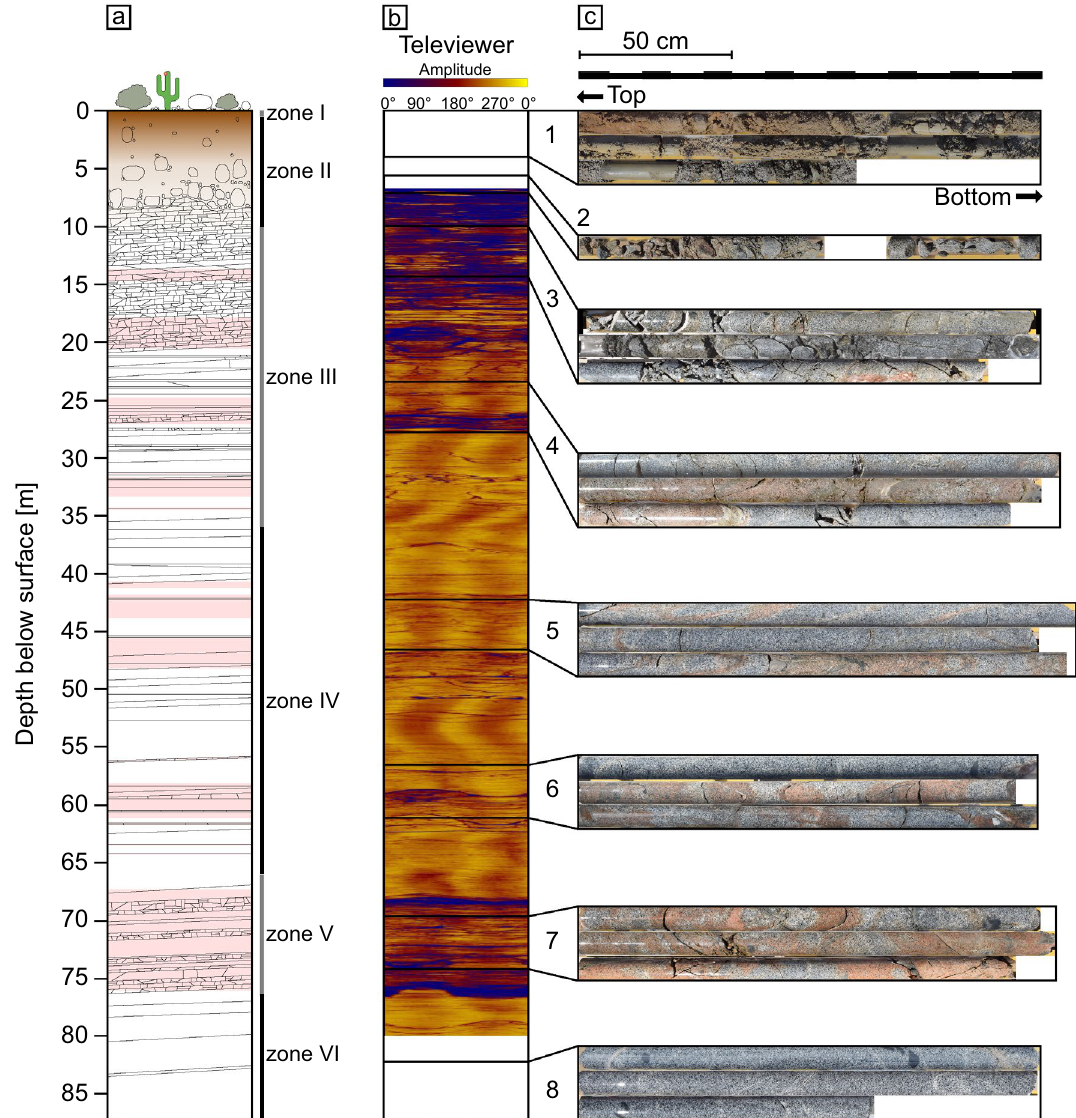
Figure 2. ( a ) Schematic core log compiled from core descriptions and -photos. Brown part in the upper metres indicates soil, pink parts indicate red-stained zones. Black lines indicate fractures but are not showing their orientation. ( b ) Acoustic televiewer image of the unrolled borehole wall from well logging. Fractures are shown as horizontal lines. Oblique fractures were projected onto the 0° azimute angle at their shallowest depth. The colours imply different amplitudes due to the varying velocity of the acoustic signal with blue indicating a low amplitude (0) and yellow a high amplitude (50,000). Details are described in the method section. ( c ) Core photos of selected zones: 1: soil and saprolite (zone I–II); 2: Saprolite (zone II); 3: Transition between saprolite and saprock (zone II–III); 4–7: saprock (zone III–V); 6: fresh bedrock (zone VI). Photos of the uppermost metres of the profile (panel 1) show drill cores from the well